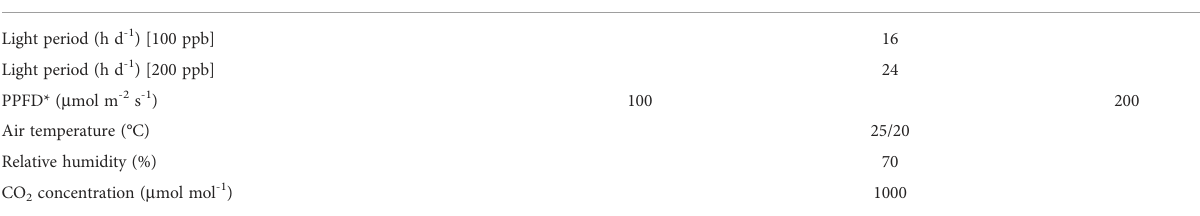
TABLE 1 Environmental conditions during ozone treatment.